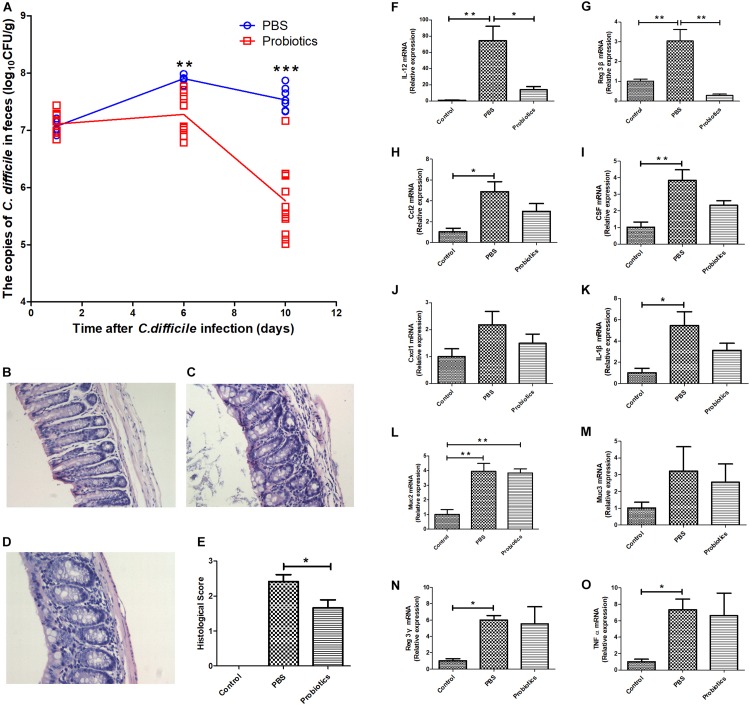
A consortium of probiotics effectively attenuated C. difficile in the feces and decreased the mRNA expressions of IL-12 and Reg3-β in colonic tissue in C. difficile-infected mouse model. (A) Mouse feces were collected at 1, 6, and 10 days after C. difficile infection. The copies of C. difficile in the feces were measured by real-time quantitative PCR. The copies of C. difficile were significantly decreased at day 6 (P< 0.01), and by day 10, the gap had widened further (P< 0.001). The data were analyzed using an unpaired t-tests, with n = 6 for each group. (B–D) Representative images of 12 Hematoxylin-Eosin staining sections, respectively, representing the control, PBS, and probiotics groups. (B) Colonic tissue of the untreated mice, and no inflammatory cell infiltration was observed. In contrast, there was great lymphocyte infiltration in the lamina propria and submucosa of the colonic tissue in (C). Additionally, the number of lymphocytes was lower in (D) than in (C), and the lymphocyte infiltration in (D) was mainly in the lamina propria. (E) Histological scores of the colon. The probiotics group was significantly lower in histological scores based on lymphocyte infiltration compared with the PBS group. (F–O) Mice were euthanized at 10 days post-treatment. The mRNA levels of the related inflammatory cytokines and intestinal mucous proteins were measured by RTq-PCR in the colon. (F–O) Represent IL-12, Reg3-β, Ccl2, CSF, Cxcl1, IL-1β, Muc2, Muc3, Reg3-γ, and TNFα, respectively. The data of E was analyzed using nonparametric tests (P< 0.05). Statistical analysis (F–O) were performed using one-way ANOVA (P < 0.05). ∗P< 0.05, ∗∗P< 0.01, ∗∗∗P< 0.001.